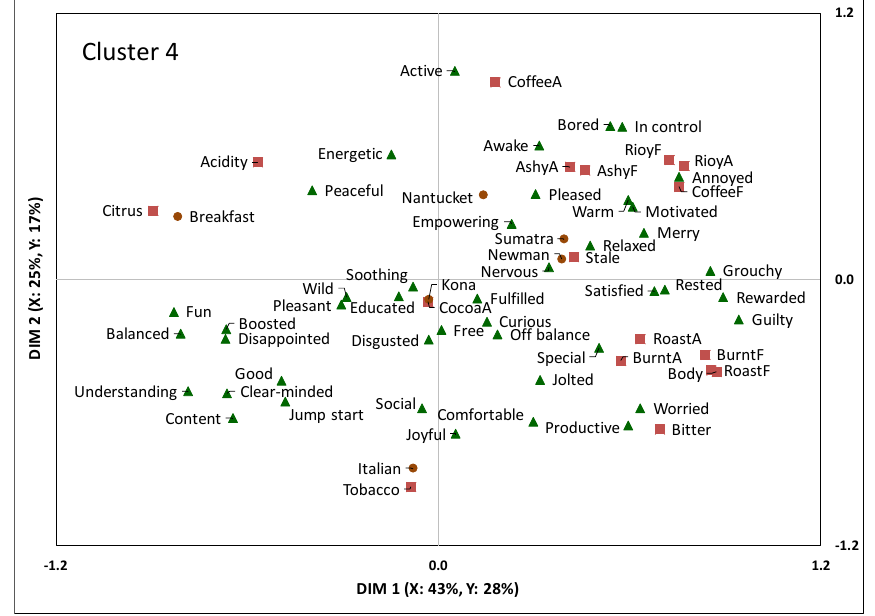
Figure 6. Partial least square regression analysis of descriptive sensory and CDE emotion lexicon of the six coffee samples for consumer Cluster 4.